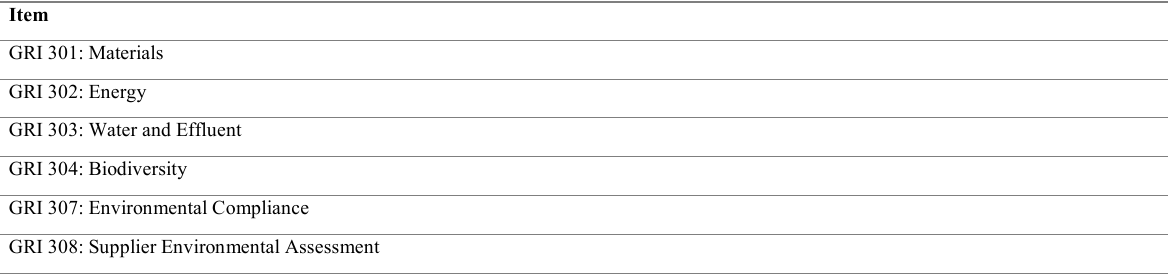
Table 5. Environmental Item for Faculty